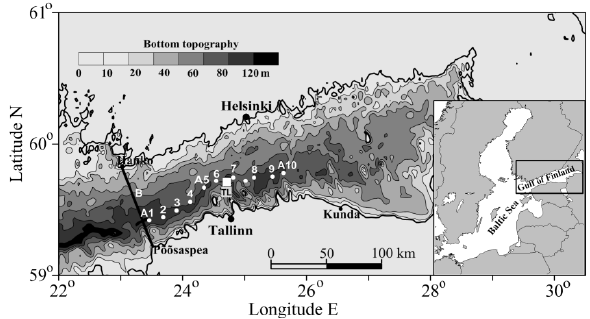
Figure 1. Map of the study area in the Gulf of Finland. The solid white circles represent the locations of the CTD stations (A1–A10) along the thalweg of the gulf. The two bottom-mounted ADCPs were located at CTD stations A3 and A9. The bottom-mounted ADCP at location A3 was equipped with a CTD and dissolved oxygen sensor. The solid white square represents the location of the wind measurements at Tallinnamadal Lighthouse (TL). The bottom topography is drawn from the gridded topography in meters (Seifert et al., 2001). The western border of the gulf is defined as a line between the towns of Põõsaspea and Hanko (line B).